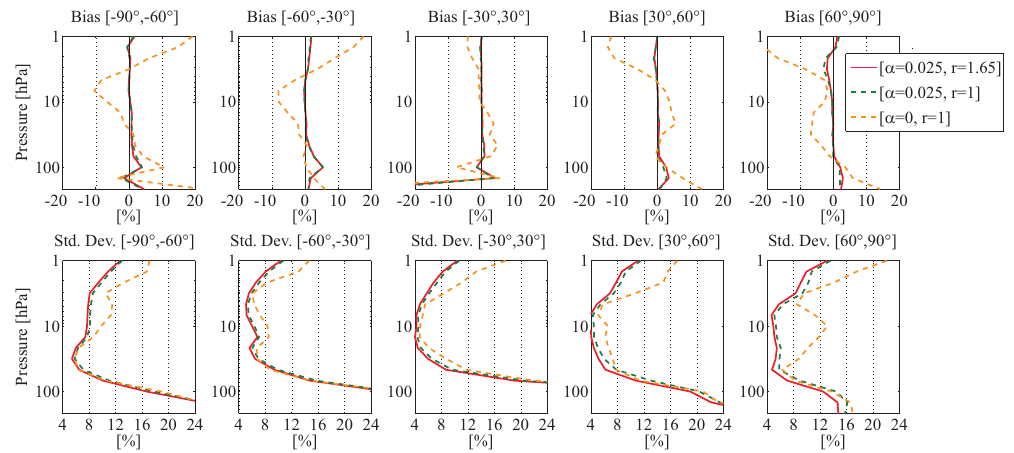
Figure 3. Observations-minus-forecast statistics, bias and standard deviation, with respect to the MLS data of the EnKF experiments using [ α = 0 ,r = 1 ] (orange dashed line), [ α = 0 . 025 ,r = 1 ] (green dashed) and [ α = 0 . 025 ,r = 1 . 65 ] (red solid) for the period from 1 May to 31 June 2008.